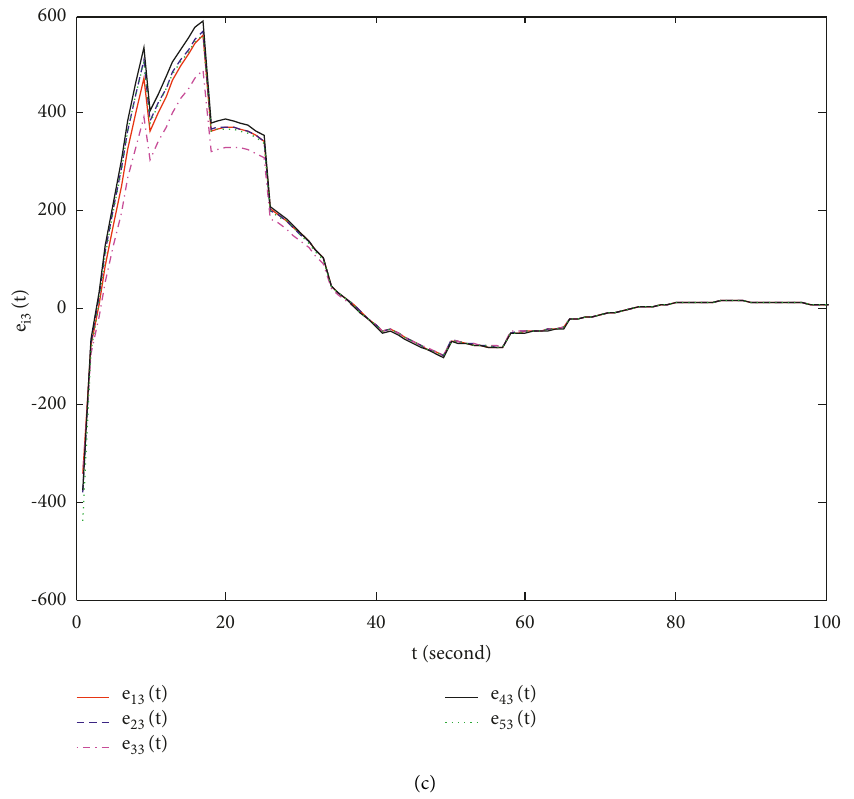
Figure 2: The error trajectories of system (9) with each node being the Chua’s system ( i � 1 , 2 , ... , 5 )